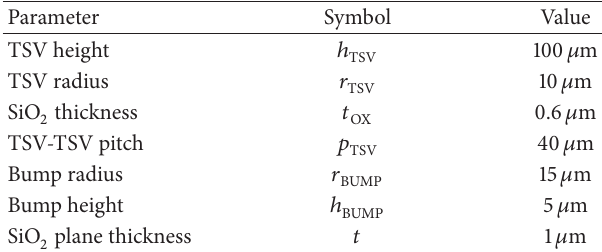
Table 1: Parameters of proposed